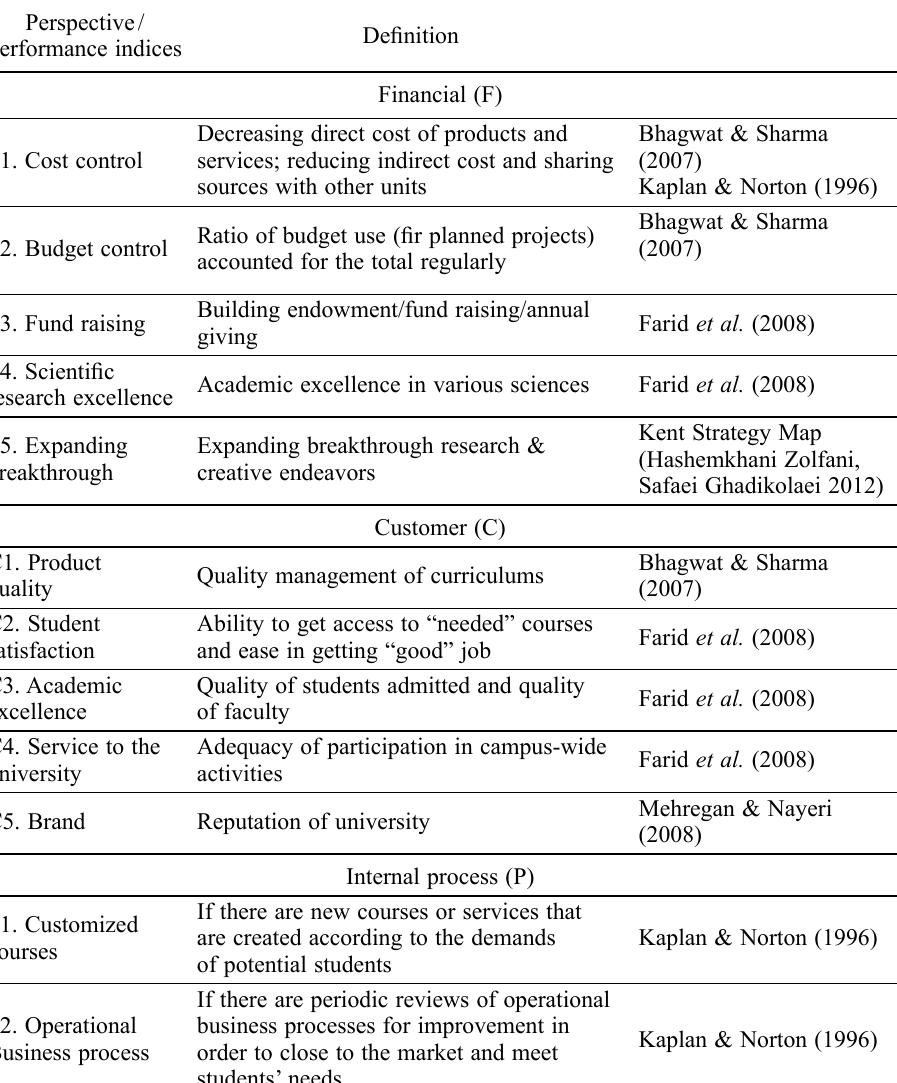
Table 3. Strategic objectives and performance measures for none governmental